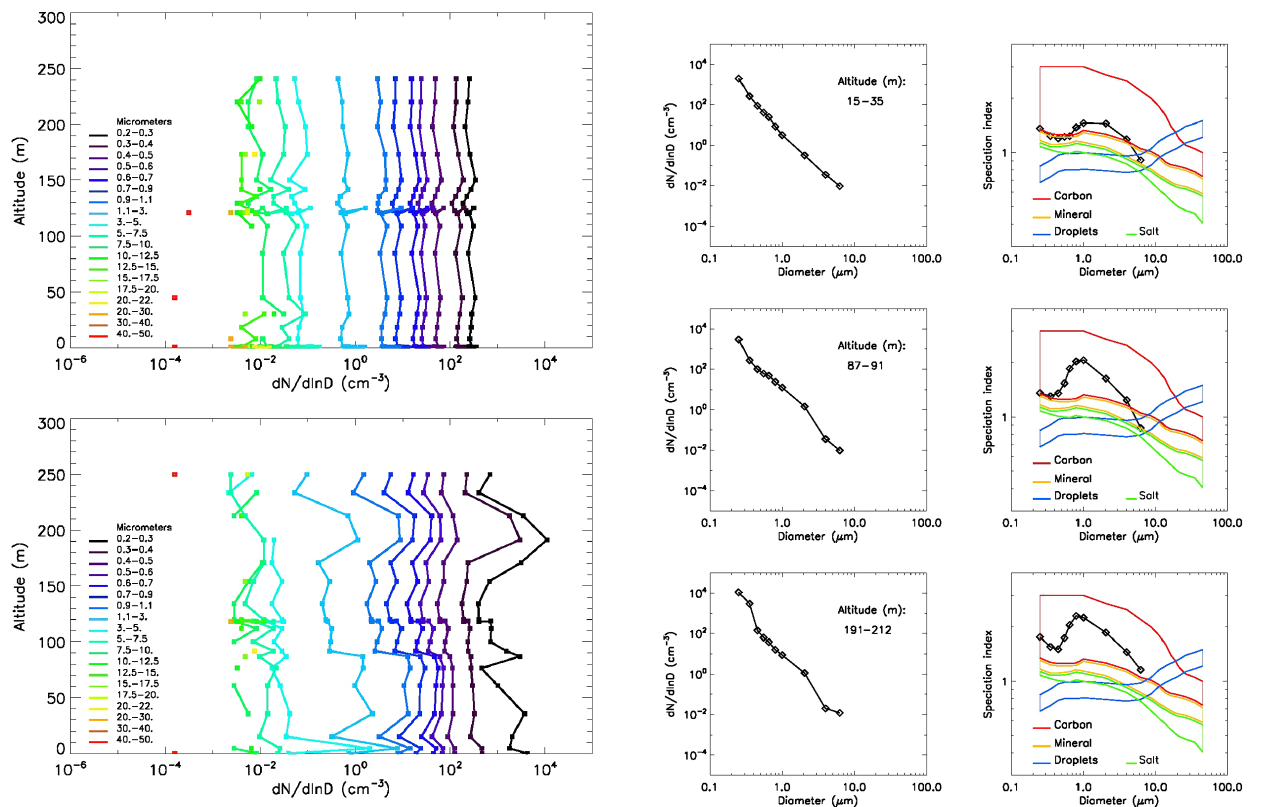
Figure 9. Size distribution and typology at three altitudes during a flight under the OAG tethered balloon in Paris (France) on 11 December 2013 at 10:15UT; the uncertainties for concentrations are the same as in Fig. 8; the sizes of the dots represent the error bars for the typology. A mixture of carbonaceous and mineral particles is detected close to the ground in the recreation park, while only carbonaceous particles are present for the highest altitudes.